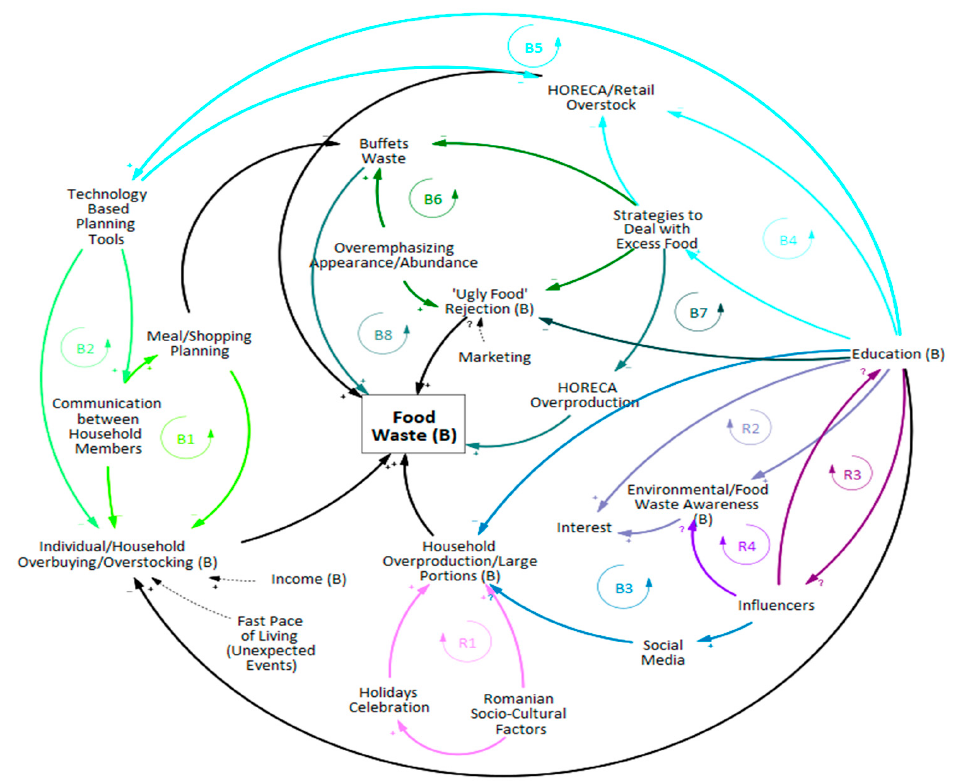
Figure A1. Food waste loop diagram elaborated during modeling session with the representatives of the business group (each color highlights a distinct loop).